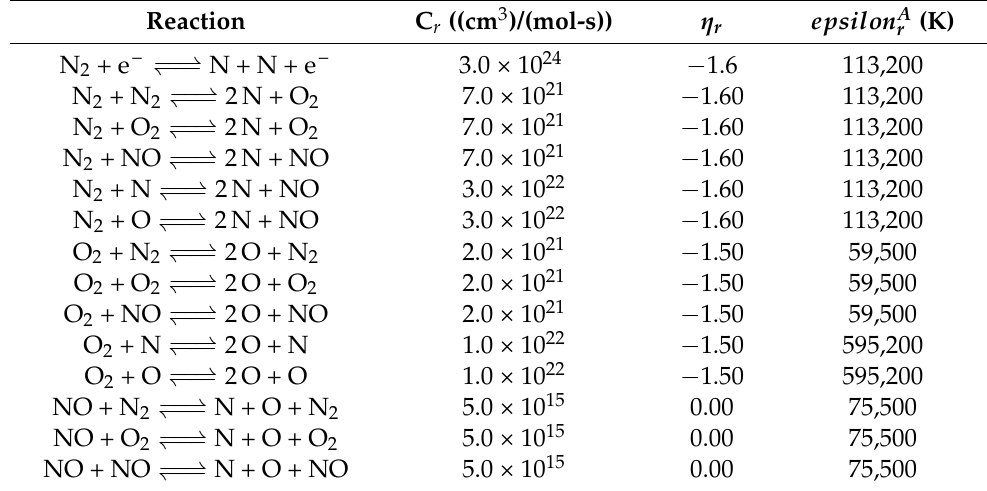
Table A1. Arrhenius parameters for forward rate